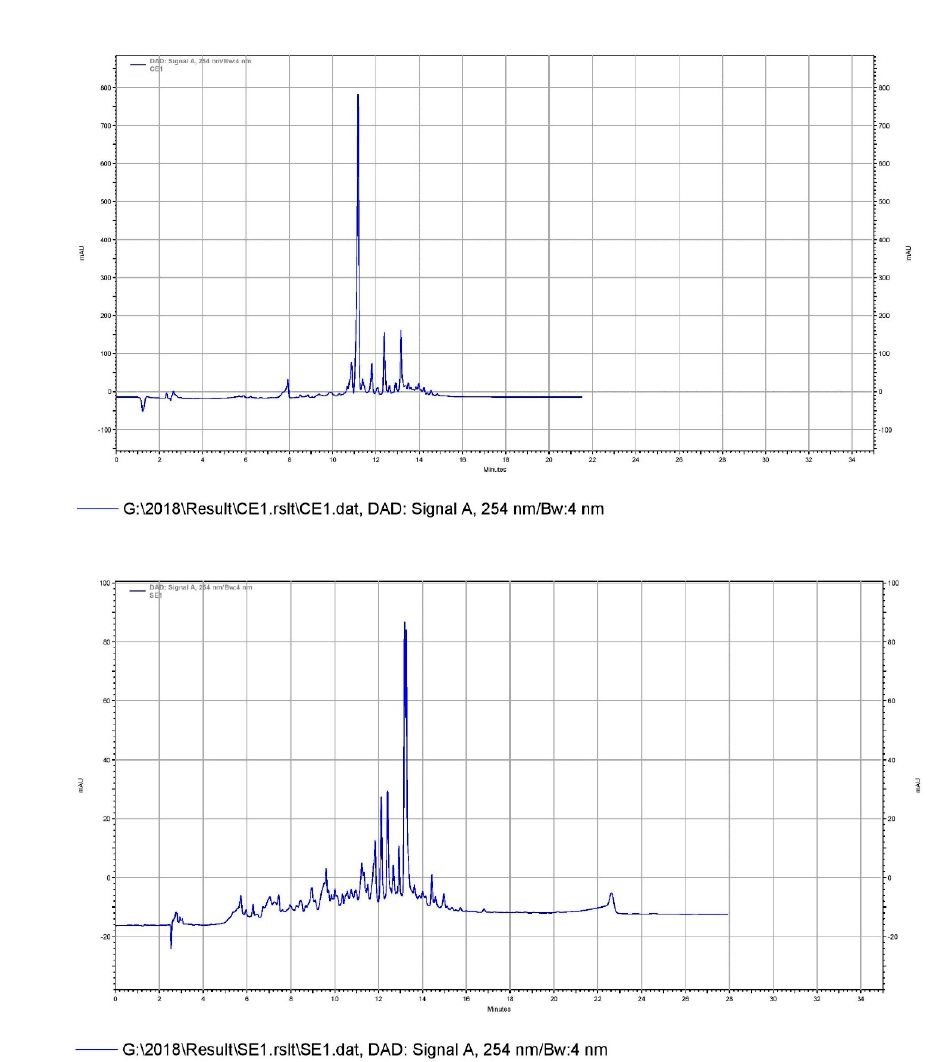
Figure 1. RP- HPLC of Metabolite extracts. ( A ). SDB with CDH- peptone and ( B ). SDB with Himedia-